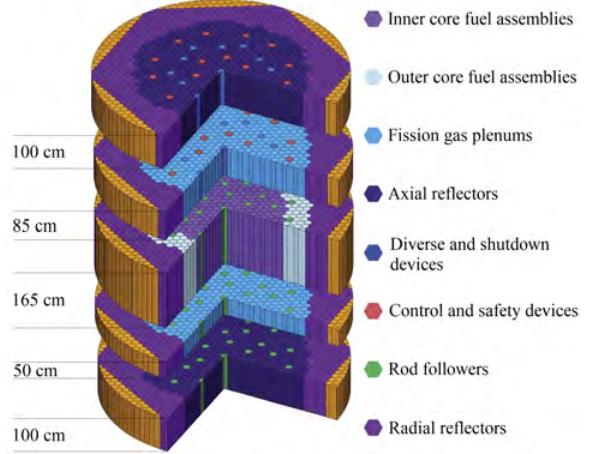
Figure 2. Cross sectional view of the GFR 2400 core [15].